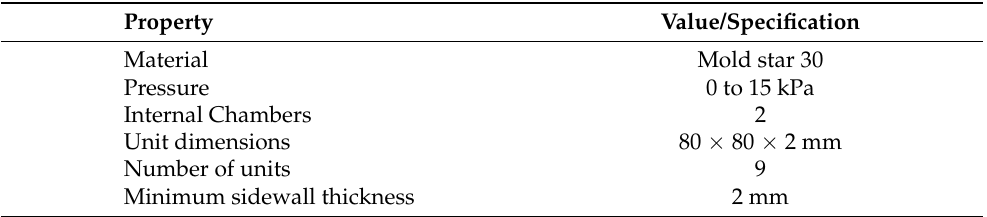
Table 2. Hierarchical framework forward pass properties. Properties were chosen based on similar